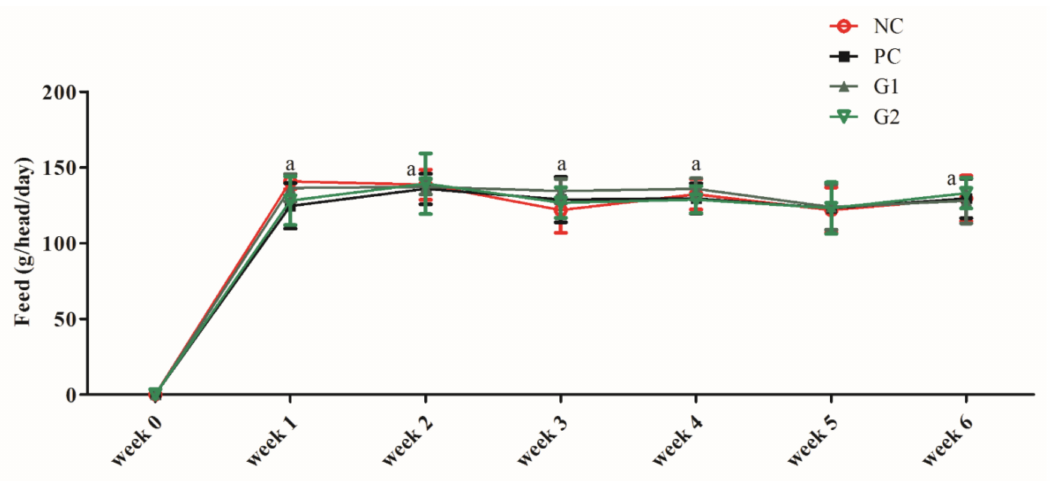
Figure 6. Each data point represents mean ± SEM from 5 determinations, and data points with the different alphabets are significantly different ( p < 0.05) using one-way ANOVA followed by Duncan tests. NC: Negative control, PC: Positive control, G1: Group 1, G2: Group